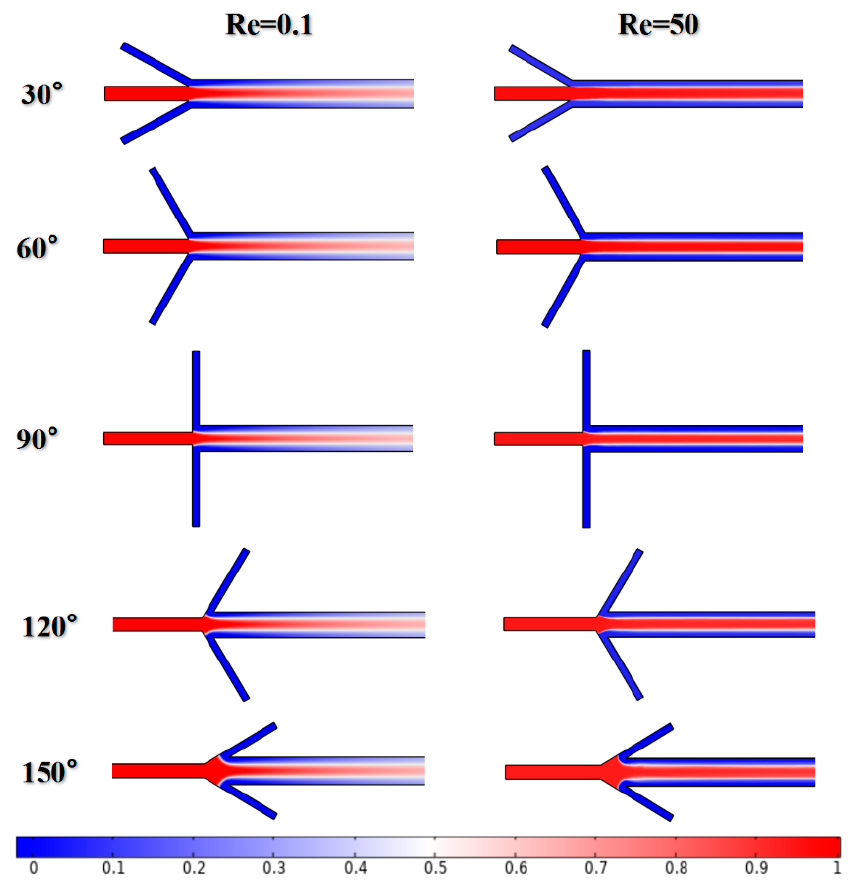
Figure 13. The molar concentration distributions with different inflow angles.